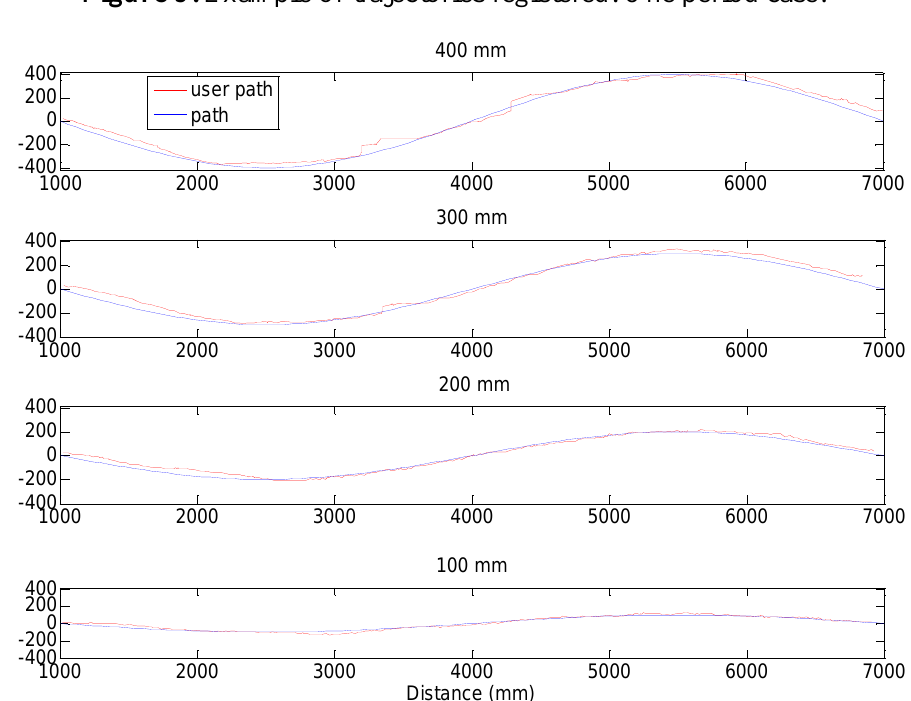
Figure 9. Example of trajectories registered: One period